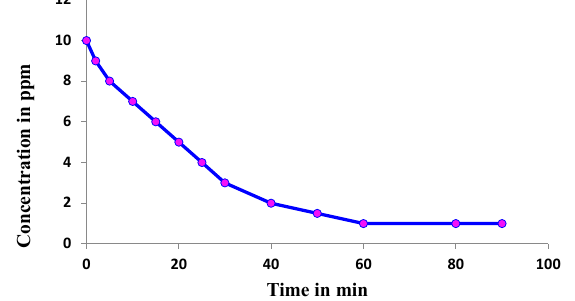
Fig. 7: Schematic representation of electrostatic interaction between protonated (ATPO-NPs) adsorbent surface and EBT dye.